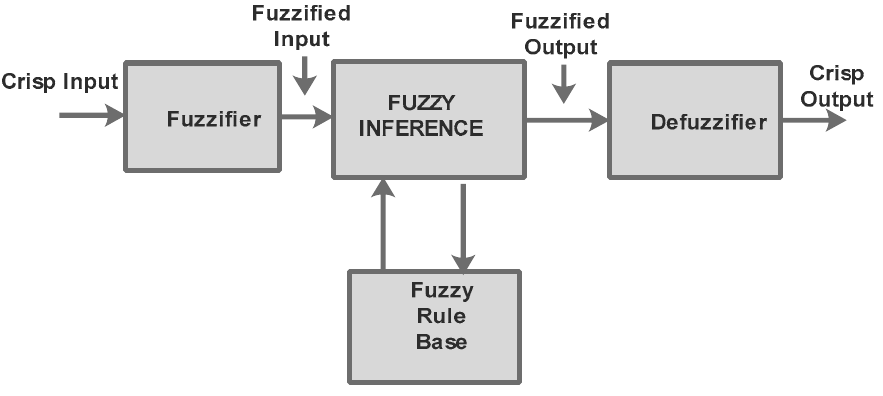
Figure 6. Schematic for a fuzzy logic controller.